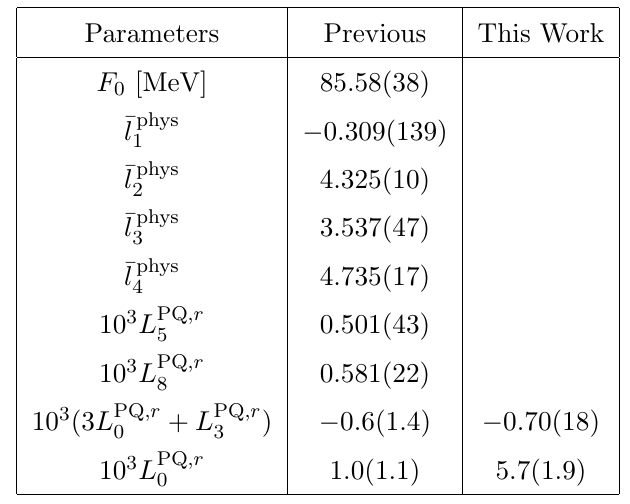
Table 2 . Parameters in SU(4 j 2) PQChPT relevant to this work. In the second column, values for the pion decay constant F 0 in the chiral limit and the physical LECs f (cid:22) l phys ref. [46], whereas f L PQ ; r